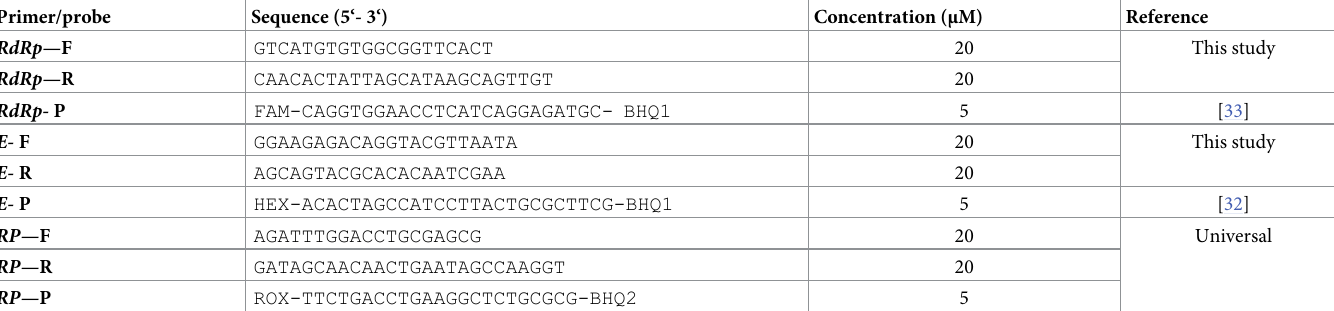
Table 1. The sequence and concentration of primer and probe sets used in PCR reactions.